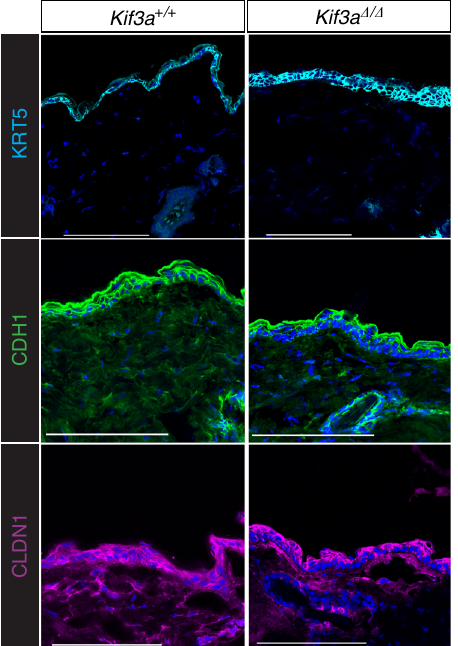
Fig. 4 Kif3a K14 Δ / Δ mice have disrupted adherens junction and tight junction markers. Epidermis sections from 8 to 10 week old Kif3a + / + and Kif3a K14 Δ / Δ mice were stained for basal cell marker keratin 5, adherens junction E-cadherin, and tight junction claudin-1, and imaged by confocal microscopy. DAPI was used as nuclei marker. Data shown here is maximum intensity projection. ( n = 15 biologically independent animals examined over two independent experiments). Scale bar: 100 μ